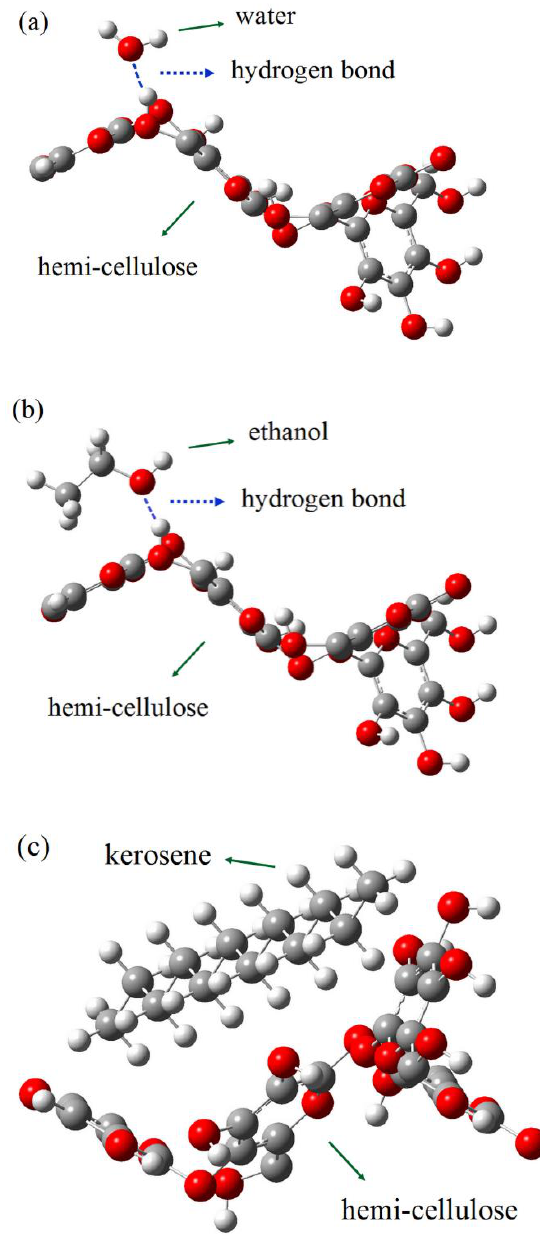
Figure 5. Schematic view of water (H 2 O) ( a ), ethanol (C 2 H 5 OH) ( b ), and kerosene (C 12 H 26 ) ( c ) molecules adsorbed on hemicellulose (the hydrogen bonds are shown with a dashed line).